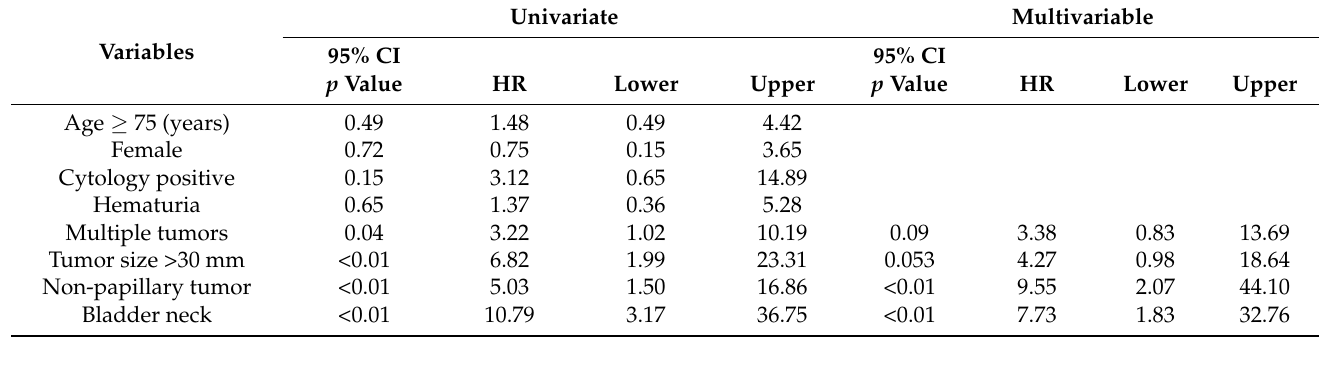
Table 2. Predictors of MIBC in patients with positive inchworm sign.